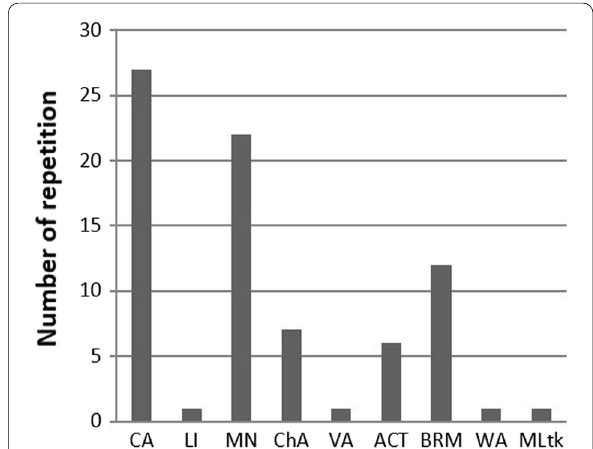
Fig. 2 Genotoxic assays used. CA, comet assay; LI, lysogenic induction assay; MN, micronucleus test; ChA, chromosomal aberration assay; VA, Vitotox assay; ACT, Allium cepa test; BRM, Bacterial reverse mutation assay; WA, Western Assay; MLtk, mouse lymphoma tk assay